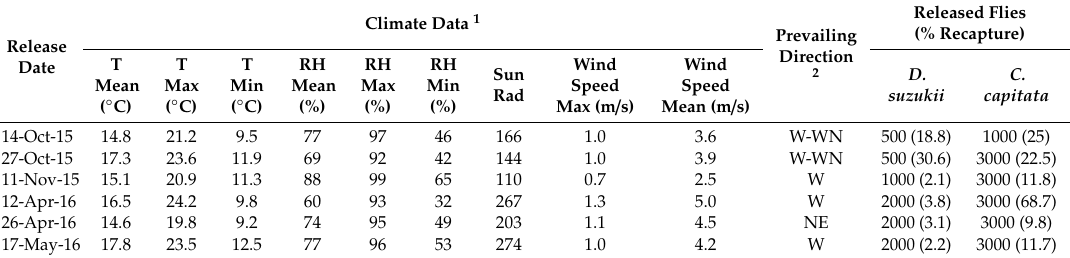
Table 1. Climate data and main features of the six mark-release–recapture